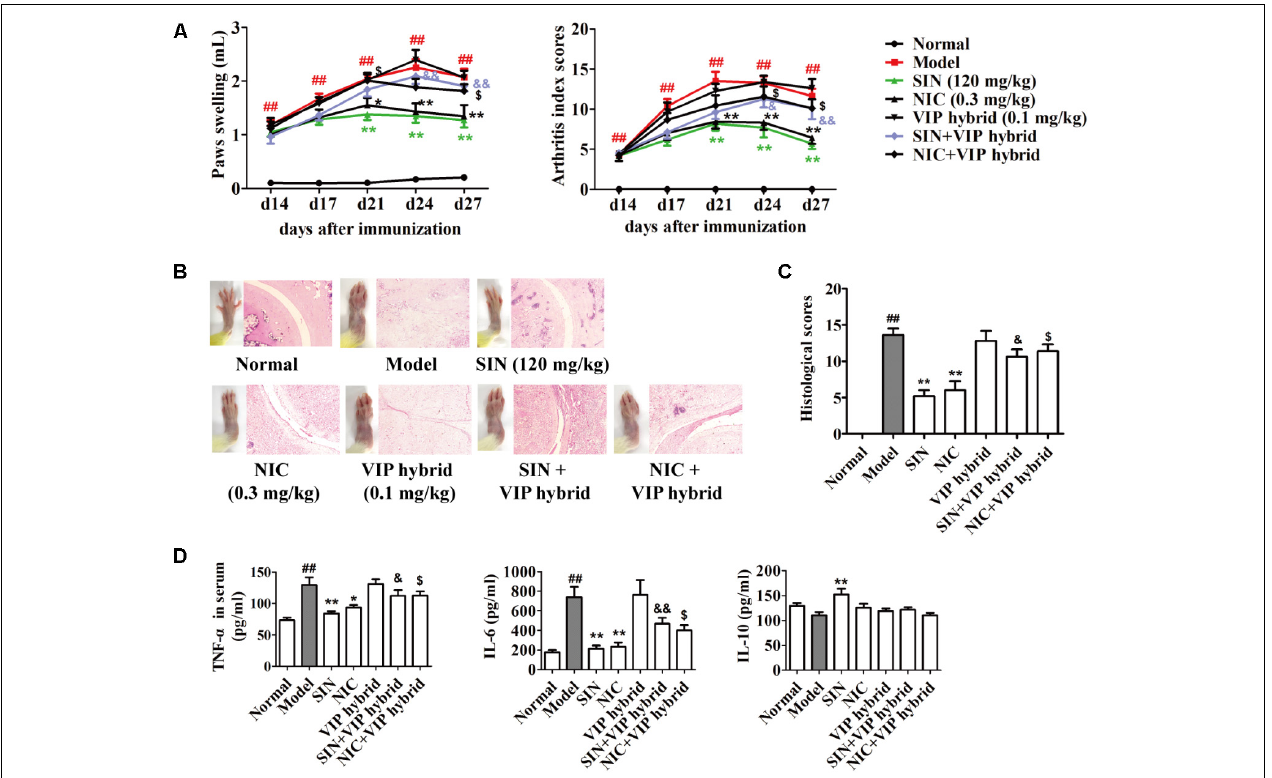
FIGURE 7 | Influence of the antagonist of VIP receptor on the anti-arthritic effect of sinomenine (SIN). Rats were intragastrically administered with SIN and intraperitoneally administered with VIP hybrid or nicotine (NIC) from day 14 to day 28. VIP hybrid was administered 30 min before the administration of vehicle, NIC or SIN. (A) The paw swelling and arthritis index were determined. (B) Photographs of representative hind paws were taken, and histopathological changes of right ankle joints in each group were determined by HE staining (original magnification 200 × ). (C) The histological scores of each group were calculated. (D) The serum levels of TNF- α , IL-6, and IL-10 were measured by ELISA. Data were expressed as means ± SEM, n = 6–8. F -values were 9.86 for paw swelling and 11.45 for arthritis index in (A) . ## P < 0.01 versus Normal; ∗ P < 0.05 and ∗∗ P < 0.01 versus Model; $ P < 0.05 versus NIC; & P < 0.05 and && P < 0.01 versus